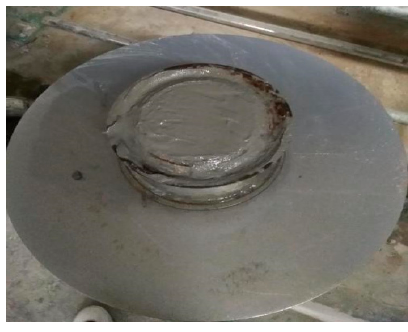
Figure 3. Slump test of P1.